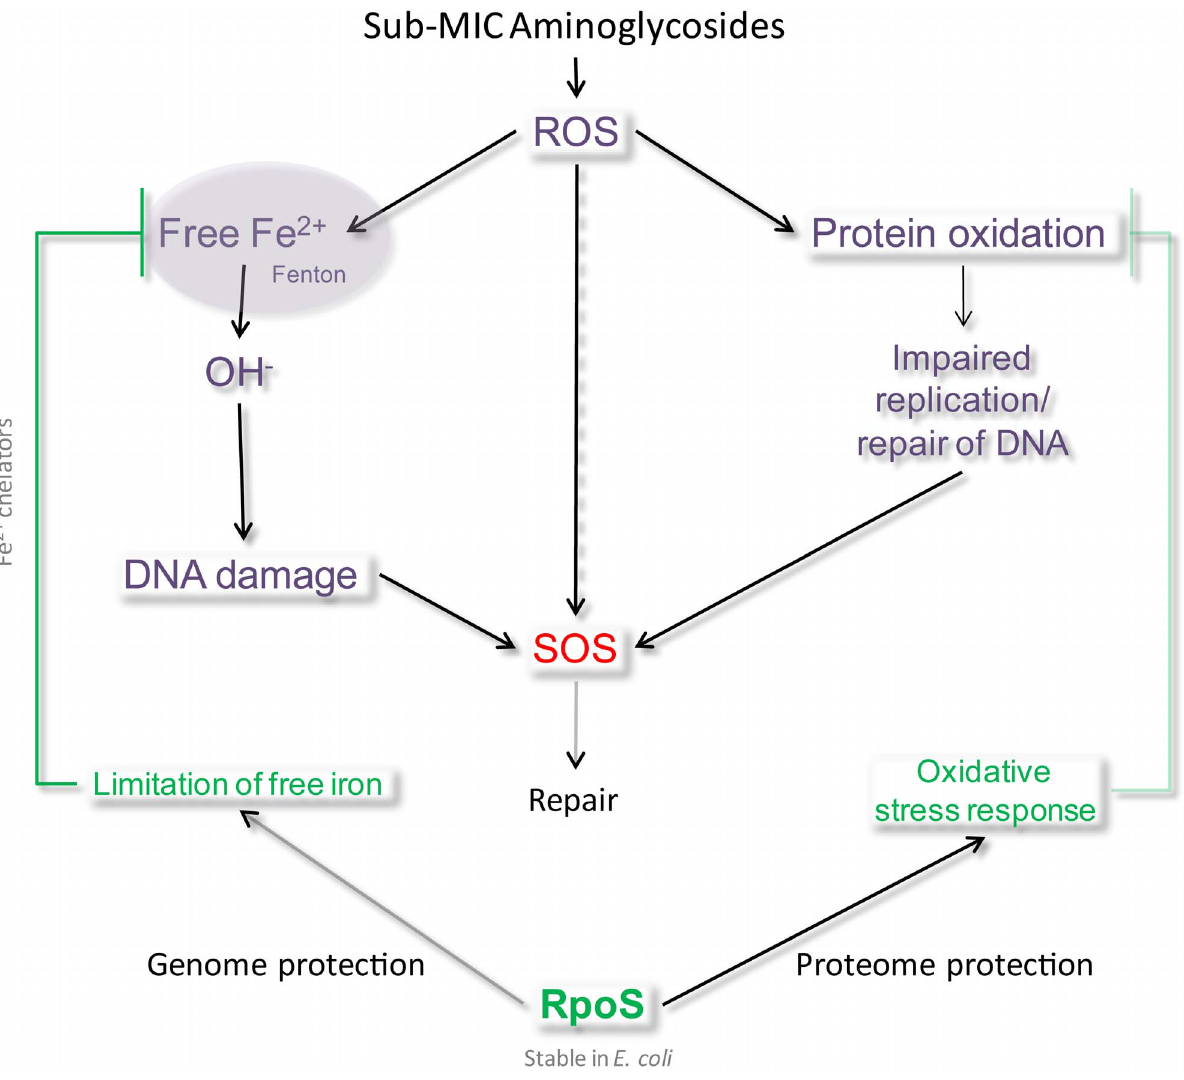
Figure 7. Model of SOS induction by sub-MIC aminoglycosides. We propose that in the presence of sub-MIC AGs, ROS are formed, inducing DNA damage directly (8-oxo-G incorporation) or indirectly (impaired DNA replication and repair proteins). When present and stable, RpoS protects cells from this type of DNA damage by activating an efficient response to oxidative stress, for instance through the decrease of intracellular iron.